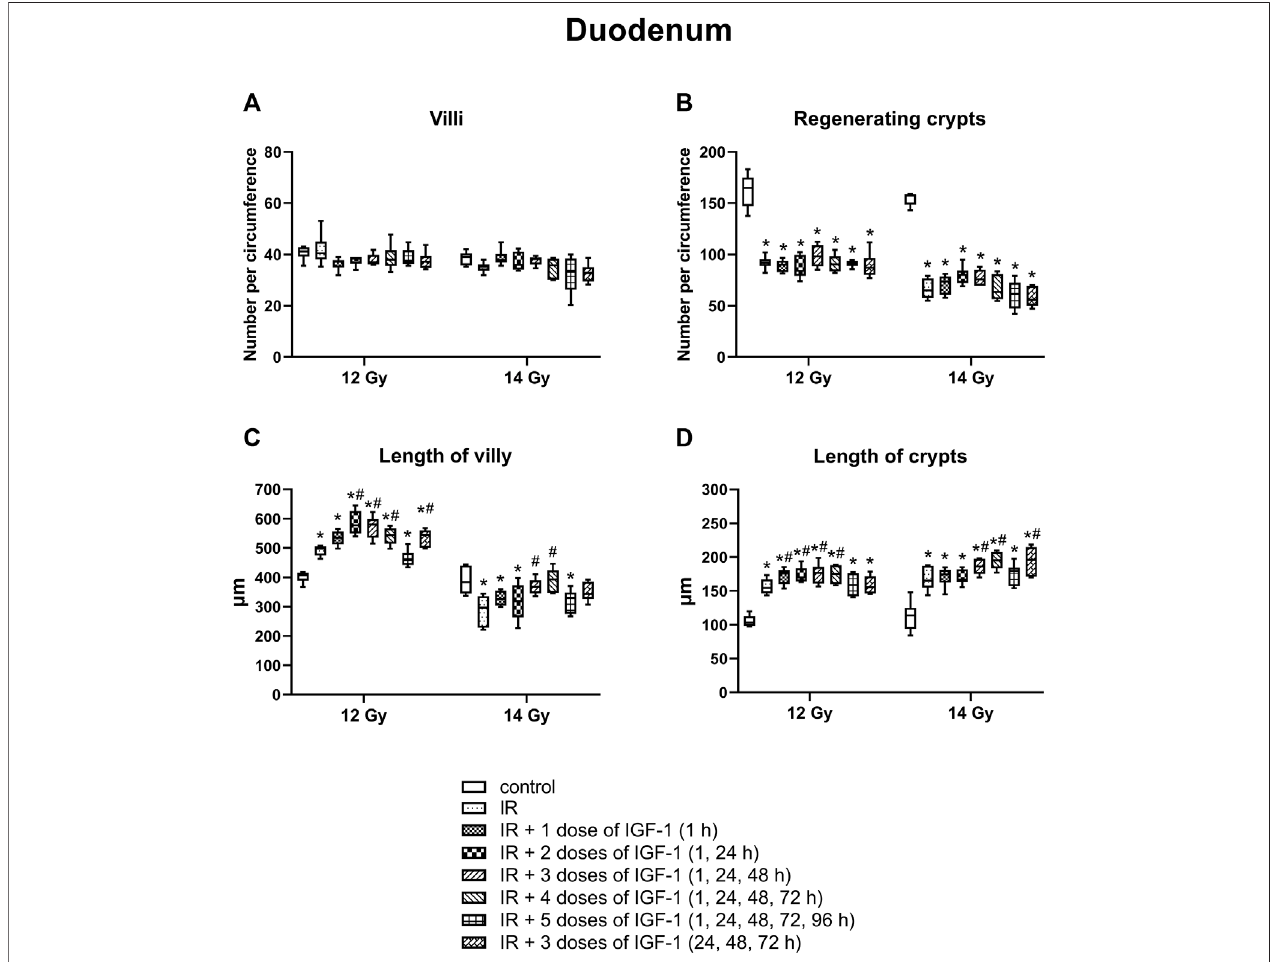
FIGURE5| EffectofdifferentIGF-1(1 mg/kg)therapeuticalregimensontheduodenumofmiceirradiatedby12or14 Gywithshieldedheadandneck. (A) number of villy. (B) number of surviving crypts (microcolony assay). (C) length of villy. (D) length of crypts. Signi fi cantly different when compared with the non-irradiated control: * p ≤ 0.05. Signi fi cantly different when compared with the solely irradiated group receiving no treatment: # p ≤ 0.05.